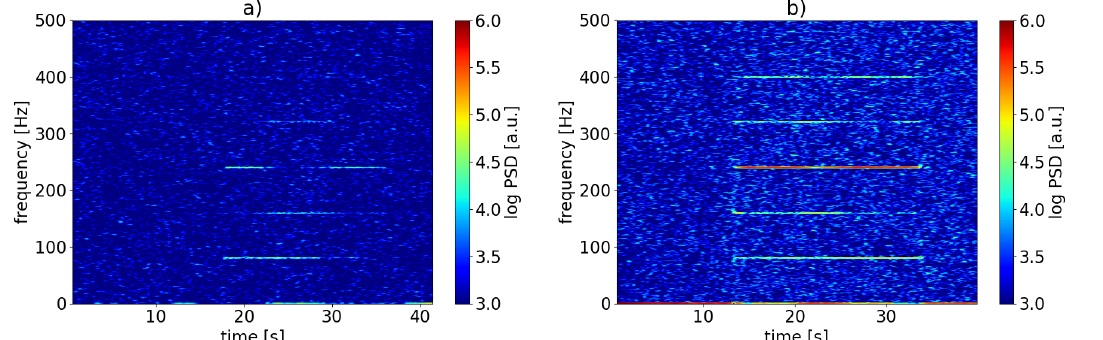
Figure 11. Spectrograms calculated from C-OTDR signals in single sensor segments within power cable with applied vibration with f = 80 Hz at a measurement distance of 55 km. ( a ) for unmodified standard SMF; ( b ) for the case using fiber-inscribed scattering